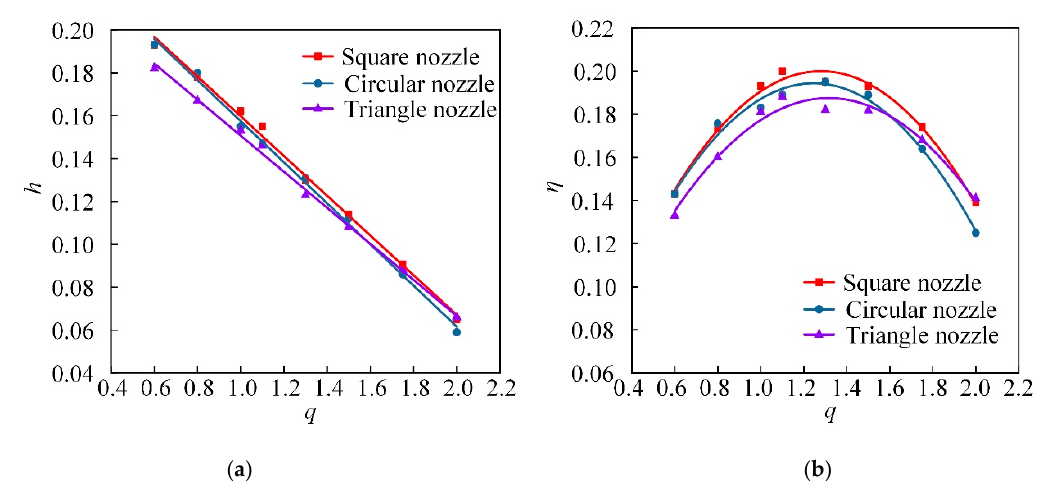
Figure 4. Pressure ratio curves and efficiency curves. ( a ) Pressure ratio; ( b ) Efficiency.